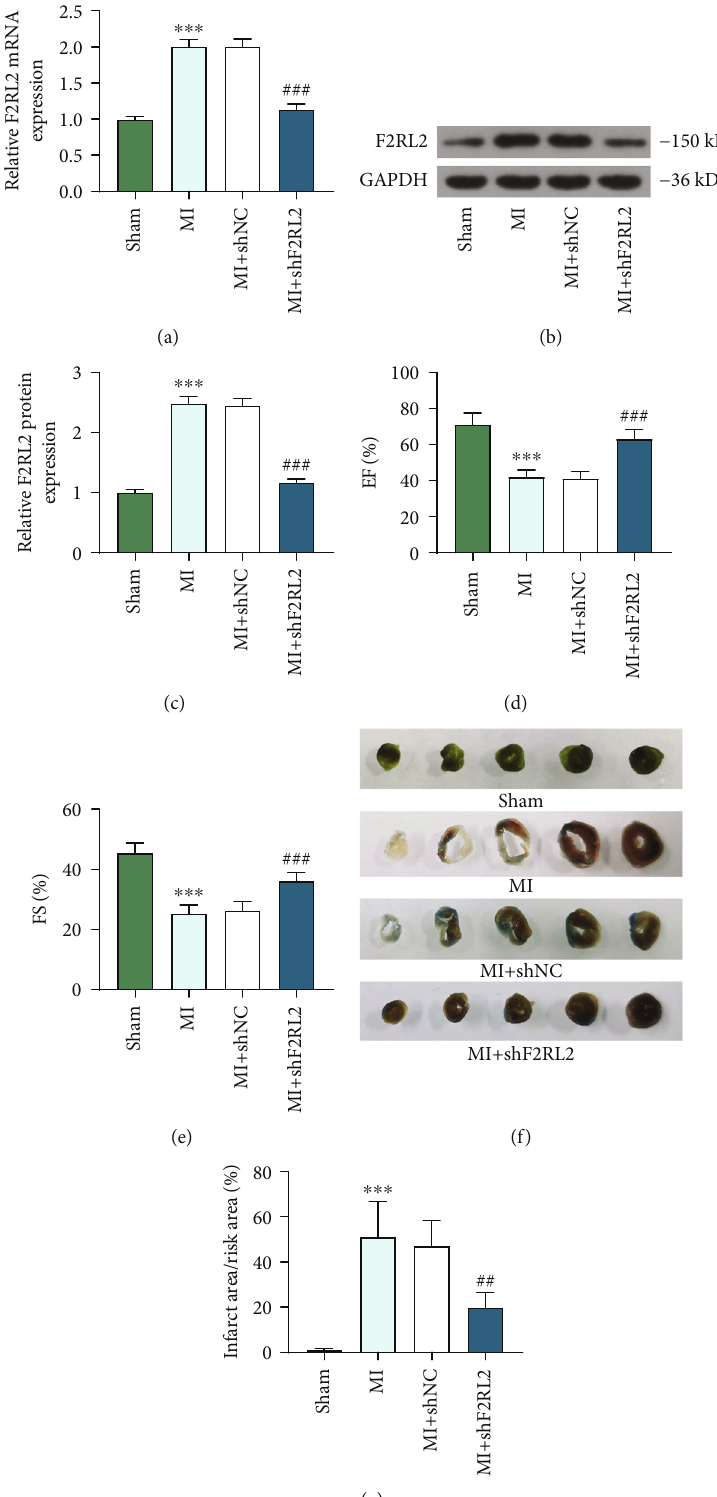
Figure 2: F2RL2 downregulation ameliorated left ventricular function and infarct area of MI mice. (a – c) The expression of F2RL2 in myocardial tissues of MI mice was examined by qRT-PCR and Western blot. (d, e) The EF (d) and FS (e) of MI mice were evaluated using echocardiography. (f, g) The infarct area of mice was examined by TTC and Evans blue staining assays. ( ∗∗∗ P < 0 : 001 , vs. sham; ## P < 0 : 01 and ### P < 0 : 001 , vs. MI+shNC) (F2RL2: coagulation factor II thrombin receptor like 2; MI: myocardial infarction; TTC: triphenyltetrazolium chloride; EF: ejection fraction; SF: fractional